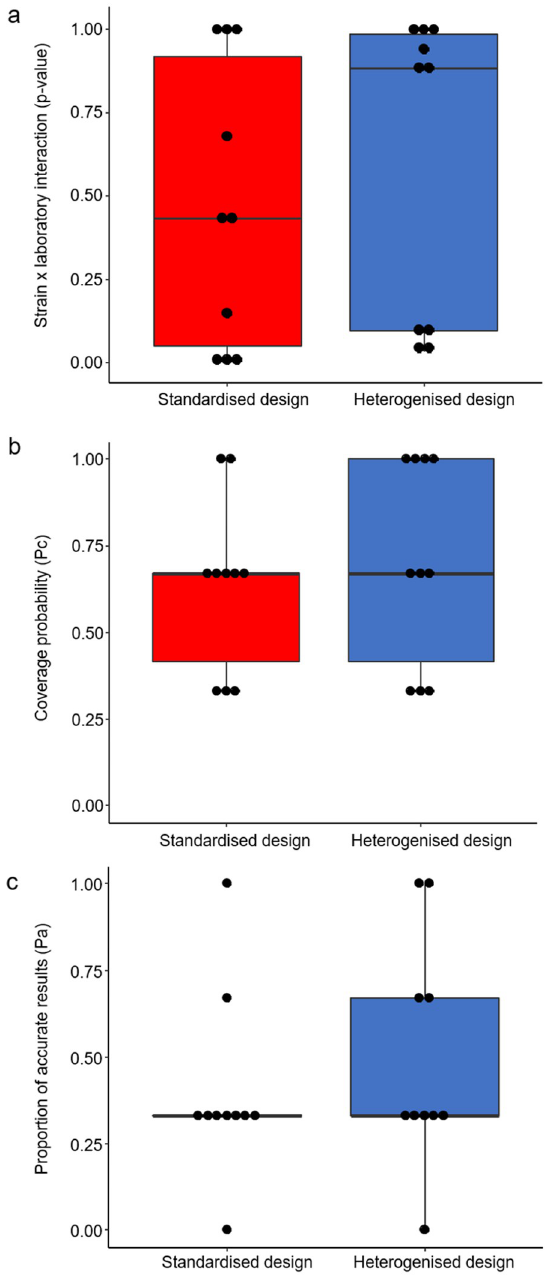
Fig 3. Comparison of the reproducibility of the strain effect across different laboratories between a standardised (red) and heterogenised design (blue). Shown are the following measurements of reproducibility: (a) Consistency of the strain effect across the 3 laboratories. This measurement is reflected by the p -value of the “strain-by-laboratory” interaction term of all 10 outcome measures. (b) Pc of all 10 outcome measures and (c) Pa of all 10 outcome measures. Data are presented as boxplots showing medians, 25% and 75% percentiles, and 5% and 95% percentiles. Black dots represent single values for each outcome measure in both designs. Statistics: Wilcoxon signed-rank test (paired, one- tailed, n = 10). The raw and processed data underlying this figure are available in the Figshare repositories https:// figshare.com/s/f327175aa8b541ef01bd and https://figshare.com/s/2245cee43a544ee1ffff. Pa, proportion of accurate results; Pc, coverage